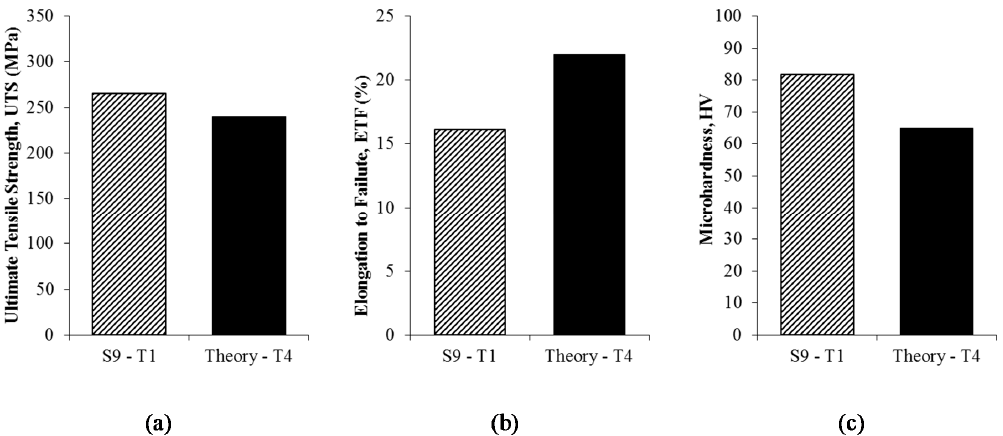
Figure 8. Results of recycled aluminium and theoretical value and as-received AA6061: ( a ) ultimate tensile strength; ( b ) elongation to failure; and ( c ) microhardness.